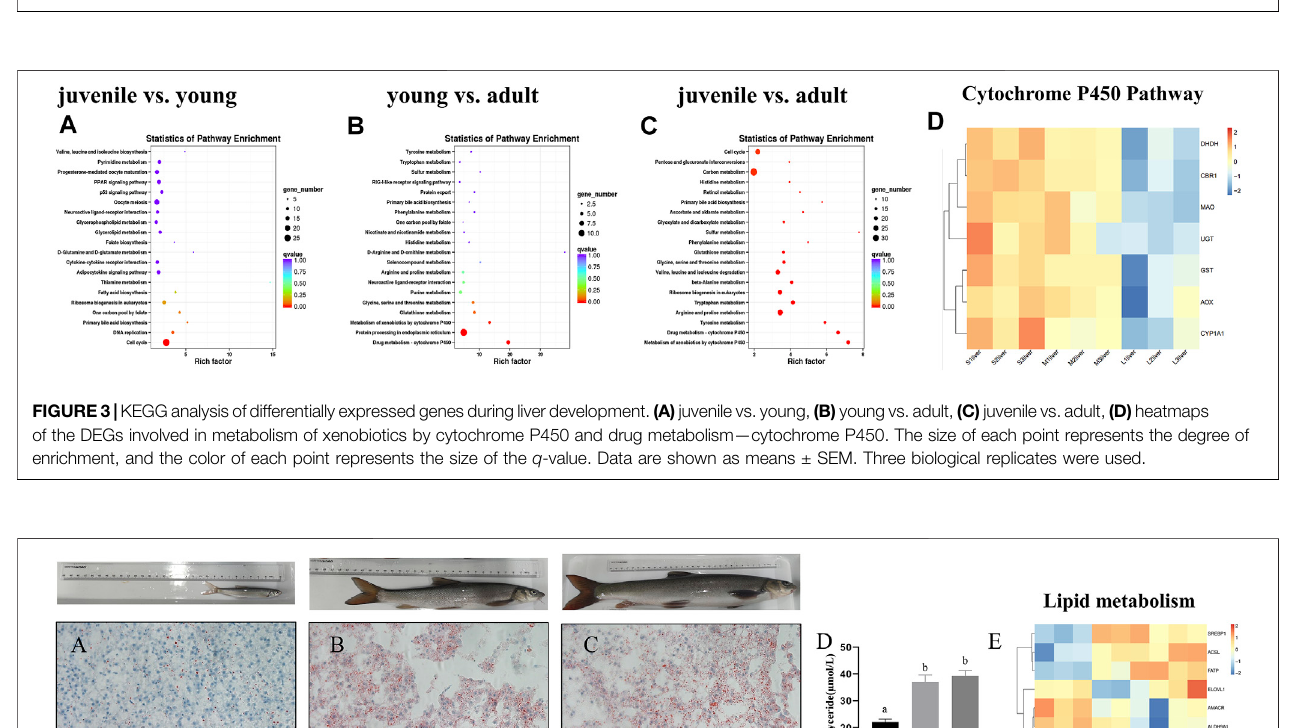
FIGURE2| Classi fi cationofdifferentexpressiongenes(DEG)withGOdatabasesa. (A) juvenilevs.young, (B) youngvs.adult, (C) juvenilevs.adult.Theabscissais the GO classi fi cation, the left of the ordinate is the percentage of transcripts, and the right is the number of transcripts. The two vertical axes are the enrichment of GO secondary functions of differentially expressed transcripts and all transcripts, respectively.